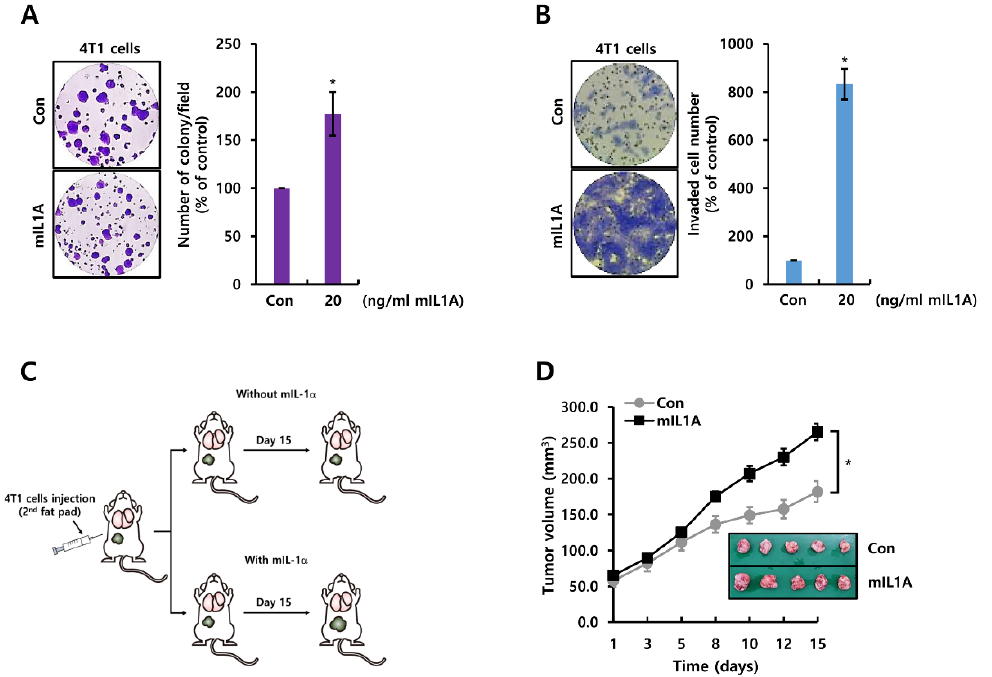
Figure 2. mIL1A augments cell growth and invasiveness in TNBC cells. ( A , B ) after cell-seeding, 4T1 TNBC cells were treated with 20 ng/mL mIL1A for two weeks ( A ) or 24 h ( B ). Cell proliferation and invasiveness were analyzed by the colony-forming assay ( A ) and the Boyden chamber assay ( B ), respectively. The upper compartment of the insert chamber was removed using cotton swabs and the bottom filters were fixed and stained for counting invaded cells. ( C ) schematic model of the experimental procedure. ( D ) the size of the tumor in each group (n = 5) was monitored for 15 days. The values are presented as the mean ± standard error of three independent experiments. * p < 0.05 vs. Con. Con; control, mIL1A; mouse IL1A.